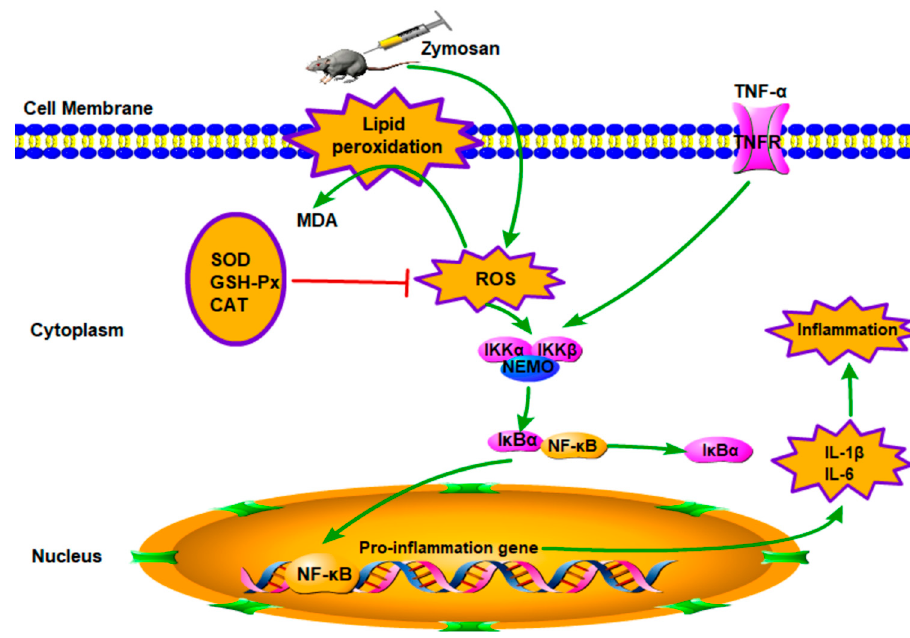
Figure 7. Schematic diagram of signal pathway related to anti-inflammatory effects of AcPPS on ALI.